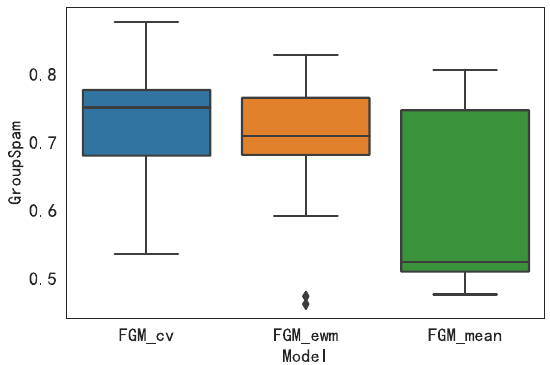
Figure 7. Boxplots of GroupSpam for Each Model. Further, the mean of the GroupSpam of each group in the same model is calculated correspondingly to obtain the average GroupSpam , represented as GroupSpam mean . The results are shown in Table 6. Table 6. The Mean of the GroupSpam Comparison.